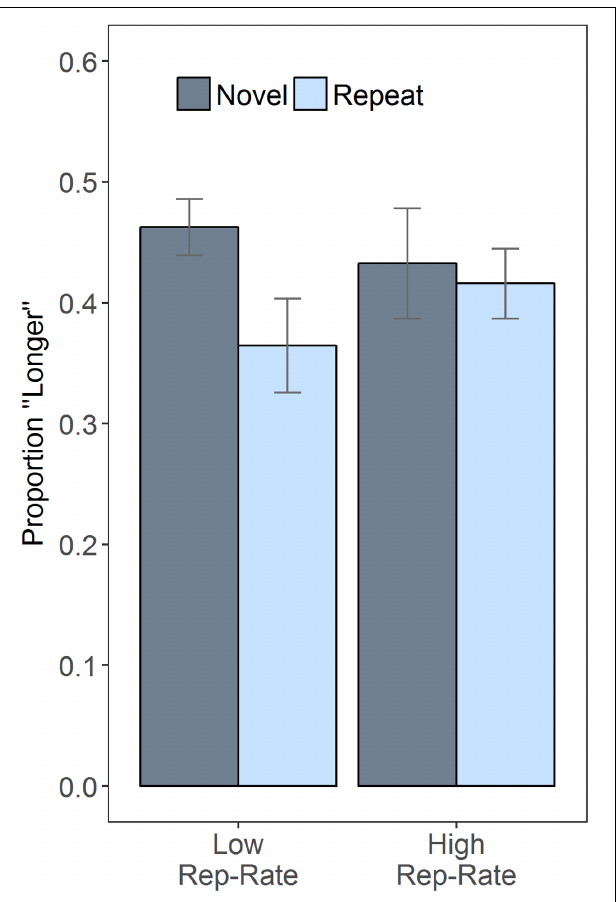
FIGURE 1 | Repetition rate (rep-rate) modulates the effects of repetition. The plot shows the proportion of trials on which the second stimulus was judged longer than the first, as a function of rep-rate and whether the second stimulus was a repeat of the first or novel. Error bars are 95% confidence intervals, calculated as described in Morey